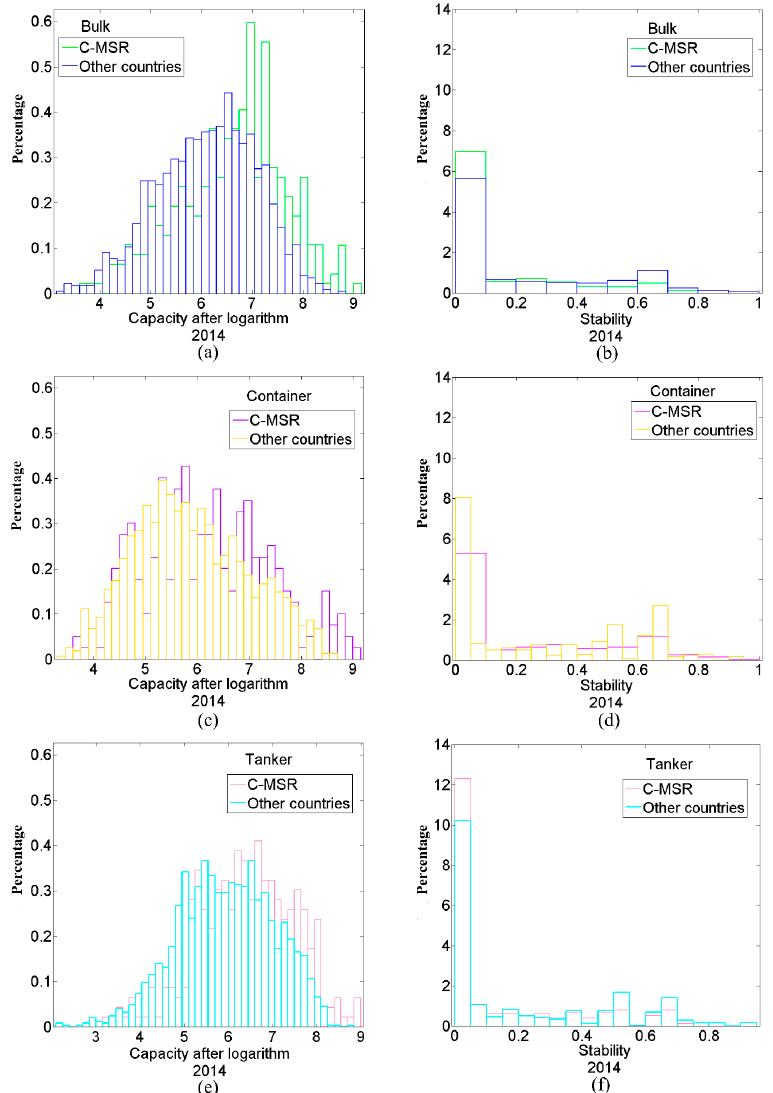
Figure 5. Capacity and stability of ports in 21C-MSR and other countries (sample in 2014). ( a ), ( b ), ( c ), Figure5. Capacityandstabilityofportsin21C-MSRandothercountries(samplein2014). ( a – f )represent ( d ), ( e ), and ( f ) represent bulk capacity after logarithm, bulk flow stability, container capacity after bulk capacity after logarithm, bulk flow stability, container capacity after logarithm, container flow stability, tanker capacity after logarithm, and tanker flow stability,